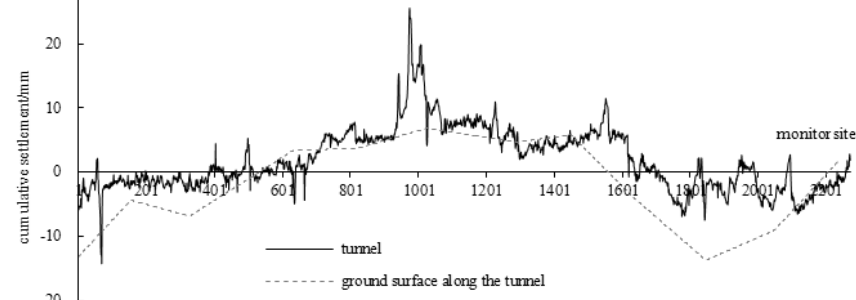
Figure 7. Graph of tunnel settlement and land subsidence along B in 2009.